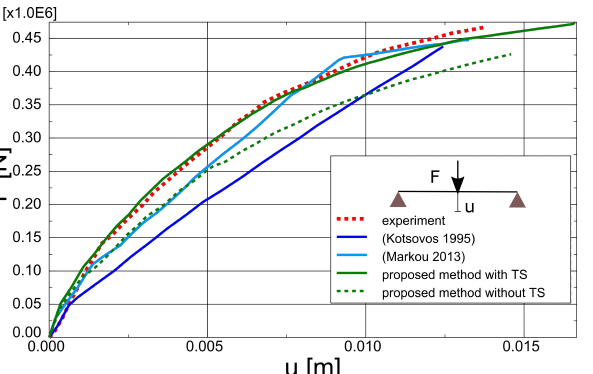
Figure 27. A-1 beam—influence of TS.